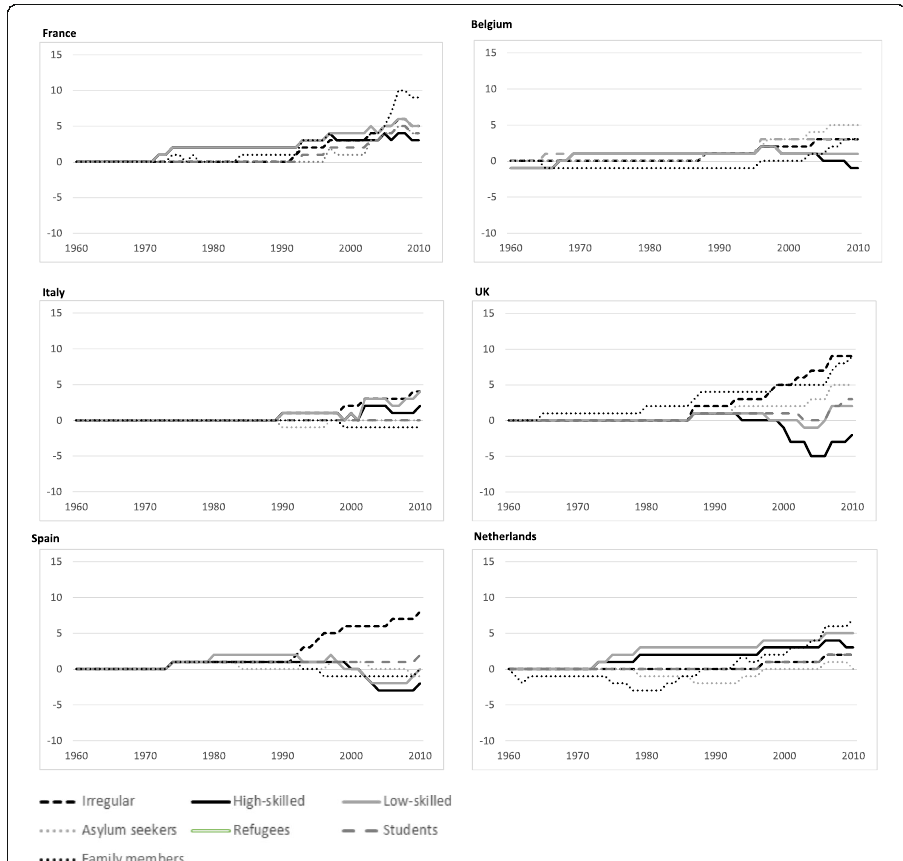
Fig. 3 Entry of non-European migrants: migration policy changes in Belgium, UK, France, Italy, Spain, and the Netherlands, 1960 – 2010. Note: Positive values on vertical axis = more restrictive. Negative values on vertical axis = less restrictive. Source: DEMIG POLICY database recoded by the